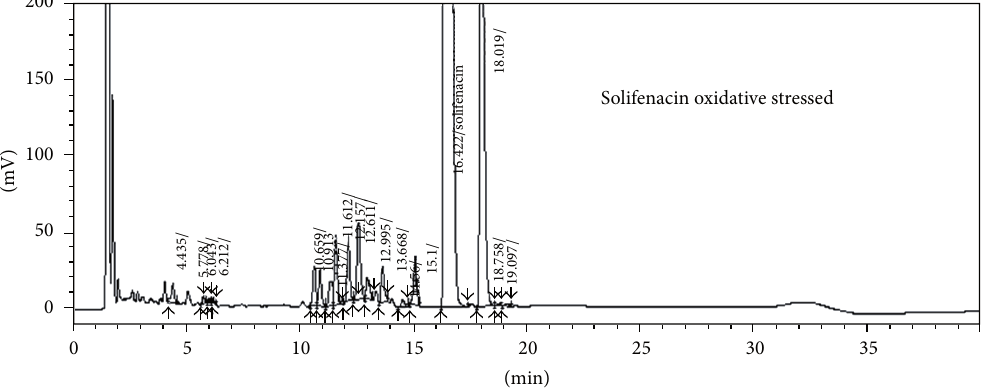
F 8: Typical HPLC chromatogram of oxidative (10